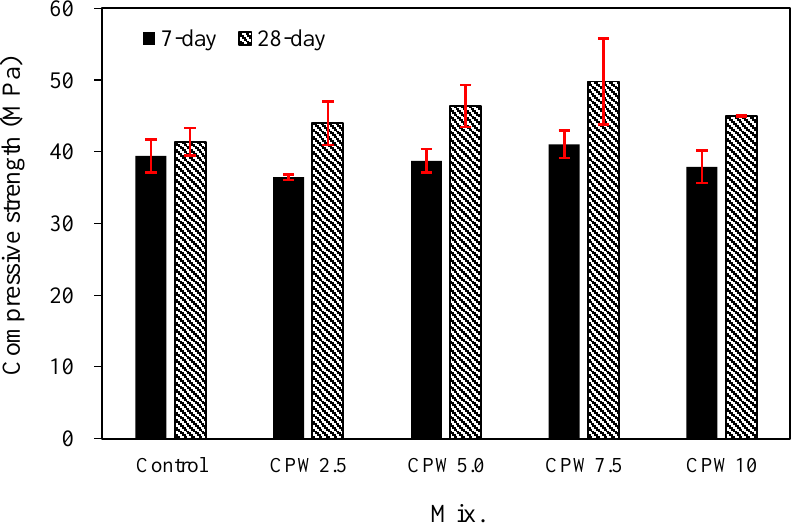
Figure 7. Compressive strength of the samples after 7 and 28 days.